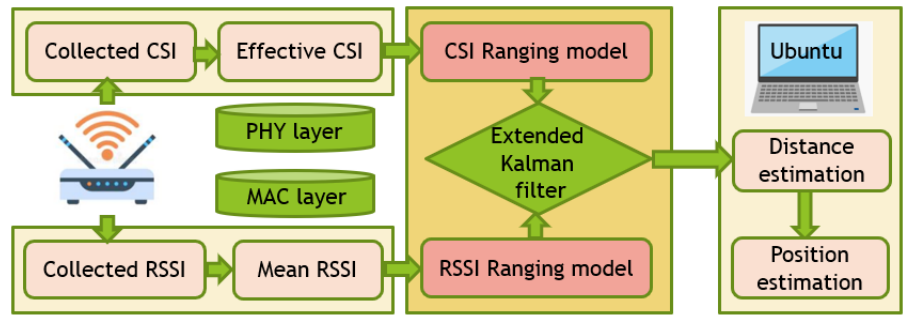
Figure 5. Indoor localization